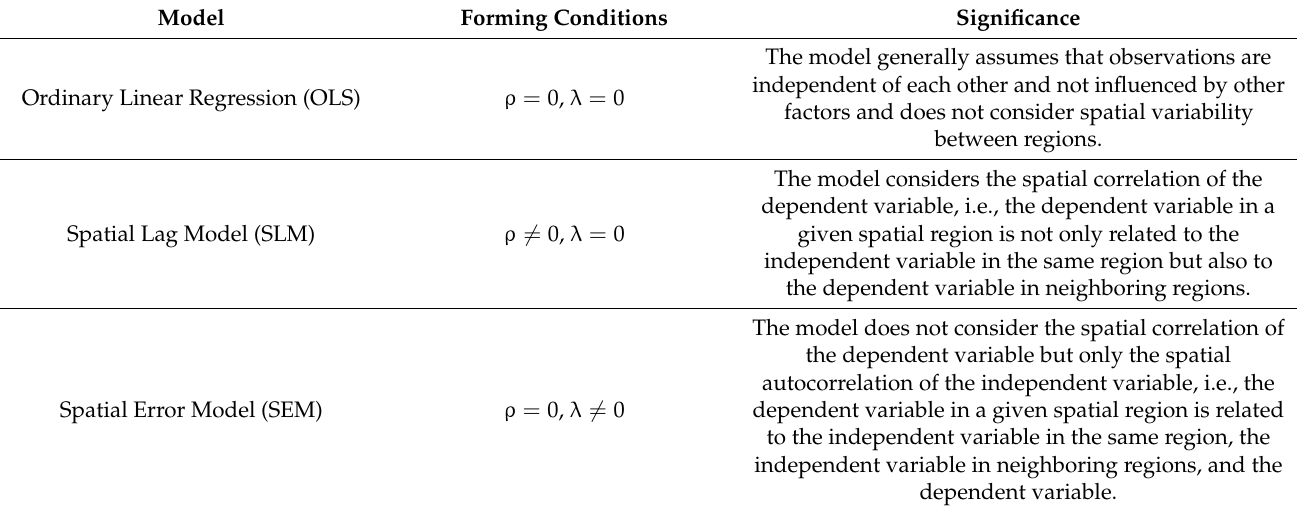
Table 2. Spatial autoregressive